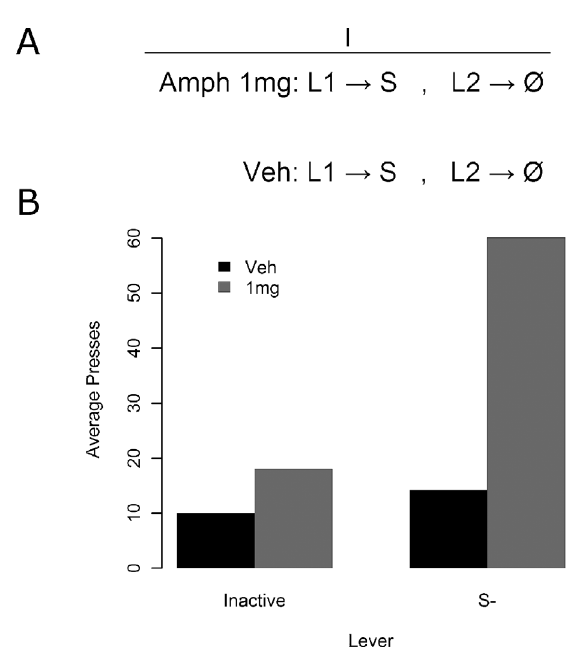
Figure 5. The effect of amphetamine on sensory reward in Experiment 4. ( A ) Experiment 4 design. All animals were given sessions both under vehicle and under 1mg/kg d-amphetamine. In these sessions they could press one lever for stimulus delivery, while the other lever had no stimulus conse- quences. ( B ) Responding was elevated under drug for the S (cid:1) , but all other points failed to reliably